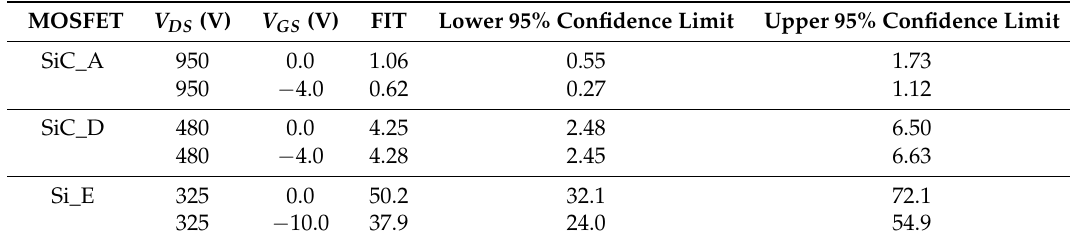
Table 4. FIT values of some power MOSFETs measured in the zero and negative gate bias conditions.